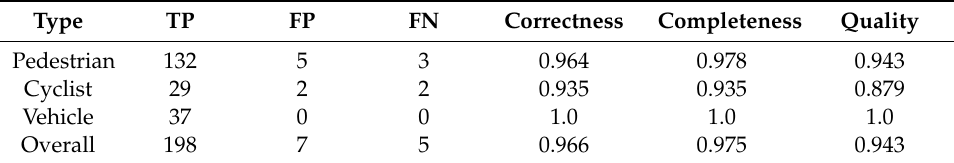
Table 1. Count results from the test UAV